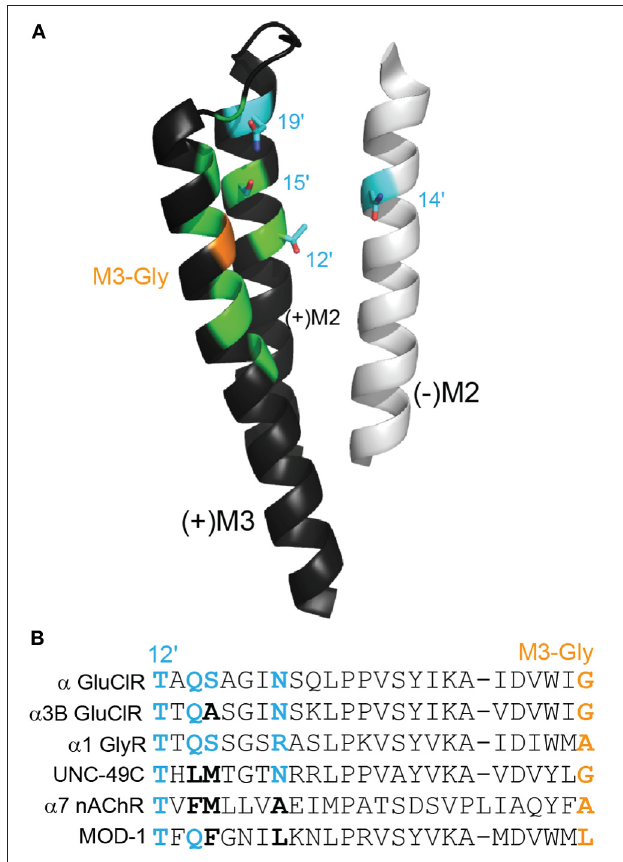
FIGURE 3 | Polar side chains near the ivermectin benzofuran. (A) ( + )M3 and ( + )M2 from the principal face and ( − )M2 from the complementary face of the ivermectin binding site in the α GluClR from C. elegans , as in Figure 2A . Polar side chains close to the bound ivermectin molecule are shown in cyan. The M3-Gly position crucial to ivermectin sensitivity is shown in orange. (B) Amino acid sequence alignment of residues, stretching from M2–12 (cid:2) to M3-Gly positions. The four cyan side chains from (A) are shown in bold in the alignment, in cyan if polar and in black if neutral. The M3-Gly position is in orange. The α GluClR from C. elegans , the α 3B GluClR from H. contortus and the human α 1 GlyR are activated by ivermectin Cully et al. (1994); McCavera et al. (2009); Shan et al. (2001), the UNC-49C (co-expressed with UNC-49B) GABA receptor from H. contortus and the human α 7 nAChR are not activated but are potentiated by ivermectin (Brown et al., 2012); Krause et al. (1998), and the MOD-1 5-HT receptor from C. elegans is insensitive to ivermectin (Ranganathan et al., 2000).